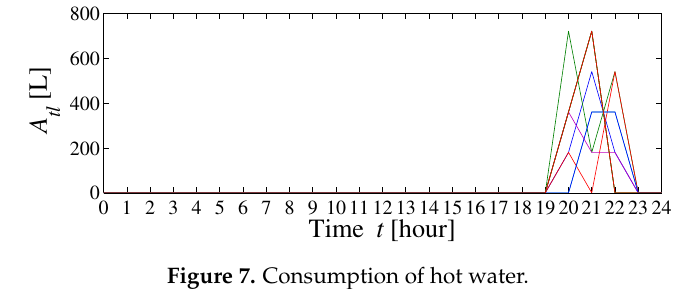
Figure 7. Consumption of hot water.